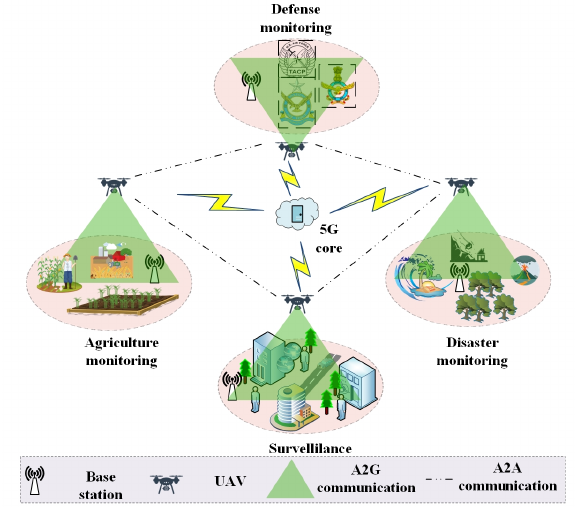
Figure 2. Applications of 5G ‐ UAV communication.